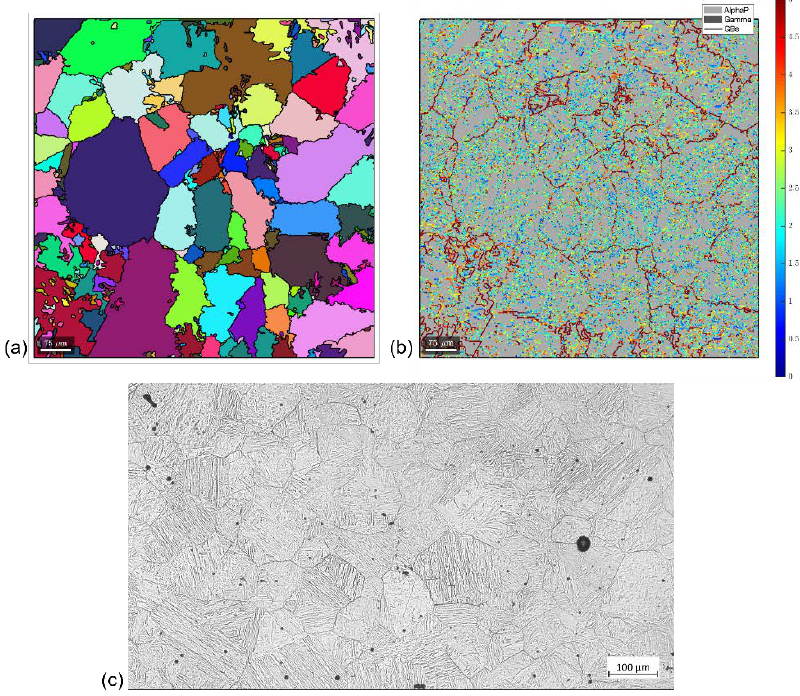
Figure 9. PAG analysis for steel A at 900 °C without deformation via ( a ) MTEX reconstruction (93 ± 8 µm diameter), ( b ) exemplified child and parent boundary misorientation and analysis via ( c ) chemical etching (91 ± 16 µm).